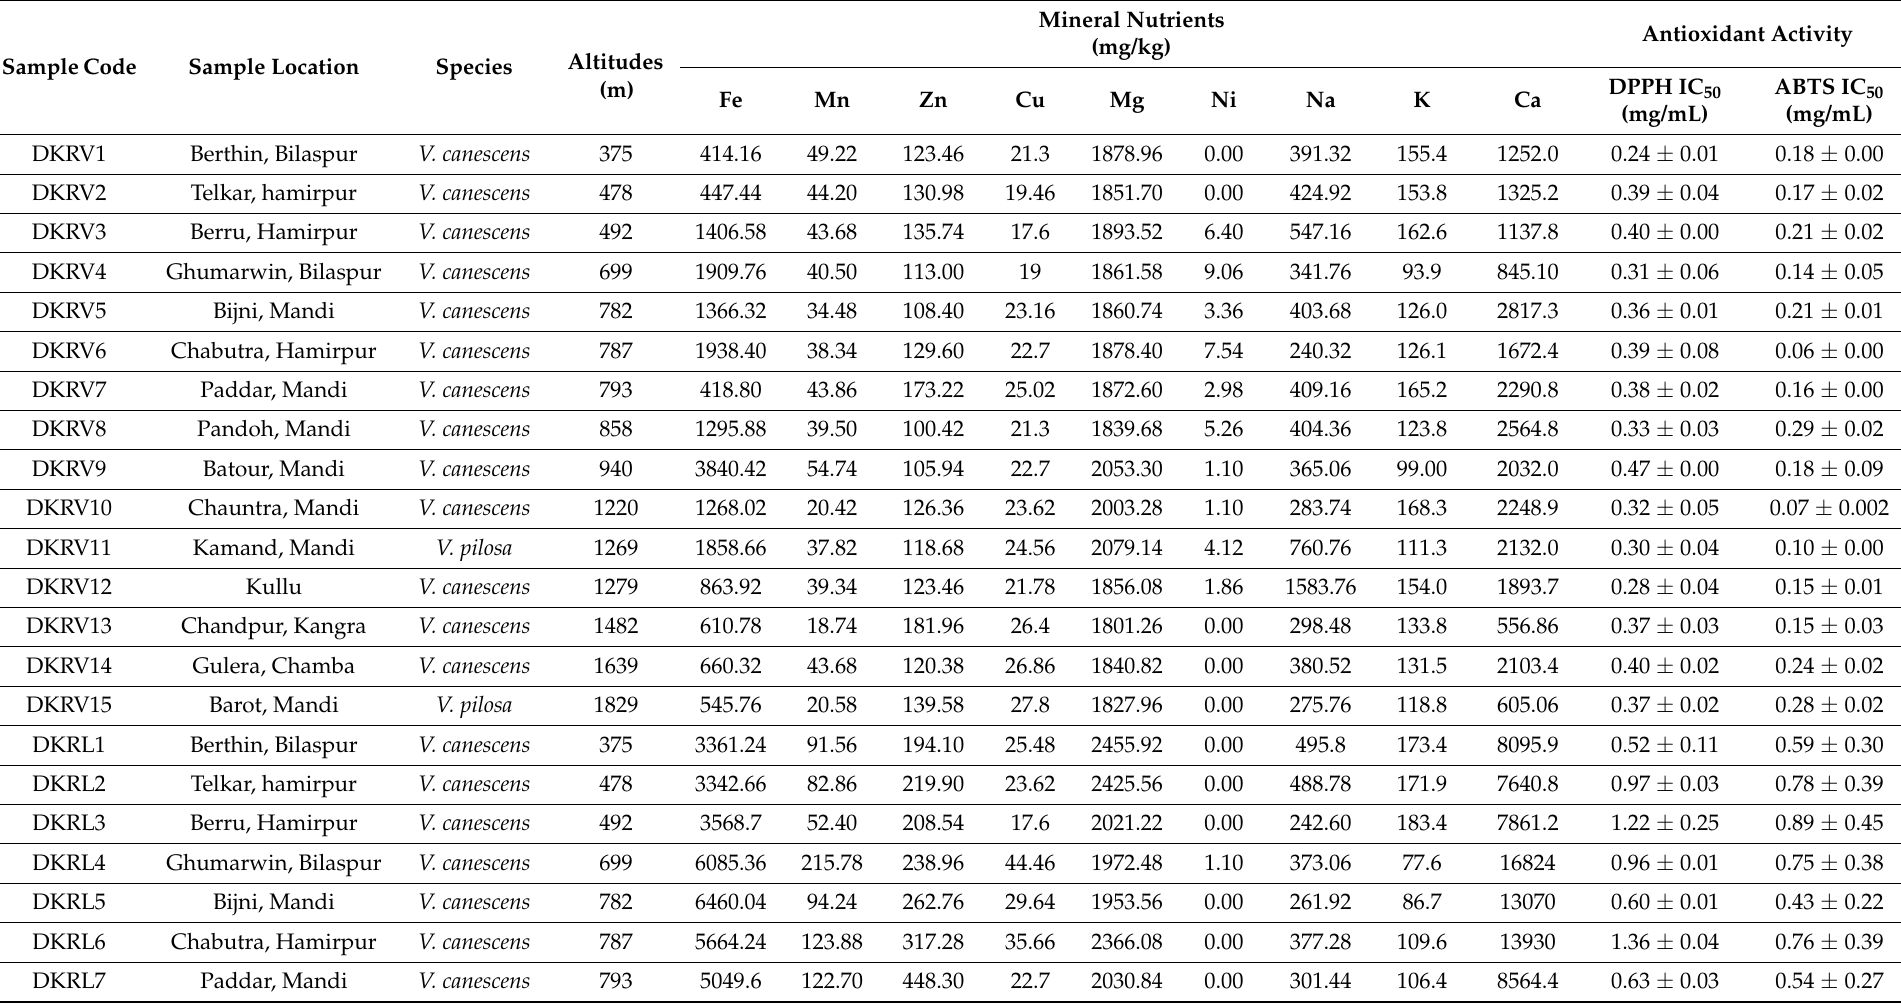
Table 1. Viola species study area (Himachal Pradesh, India), Altitudes, Nutritional profiling (Total phenolic and flavonoid contents and minerals), and antioxi- dant